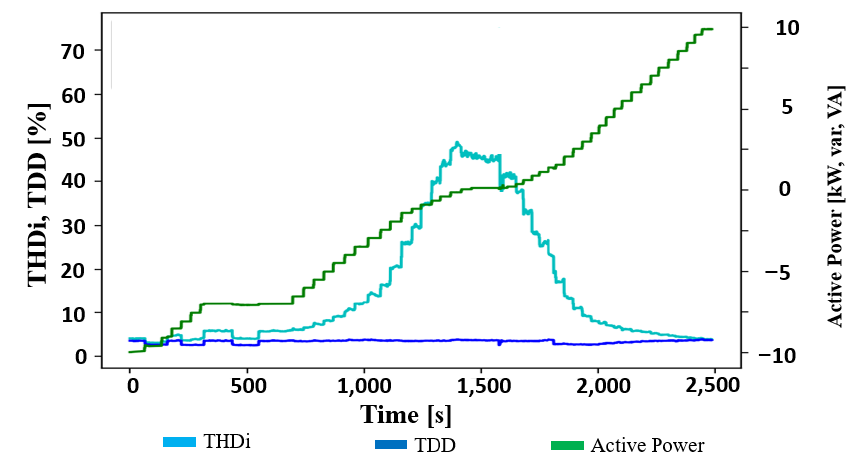
Figure 9. THD i and TDD at different power set-points.